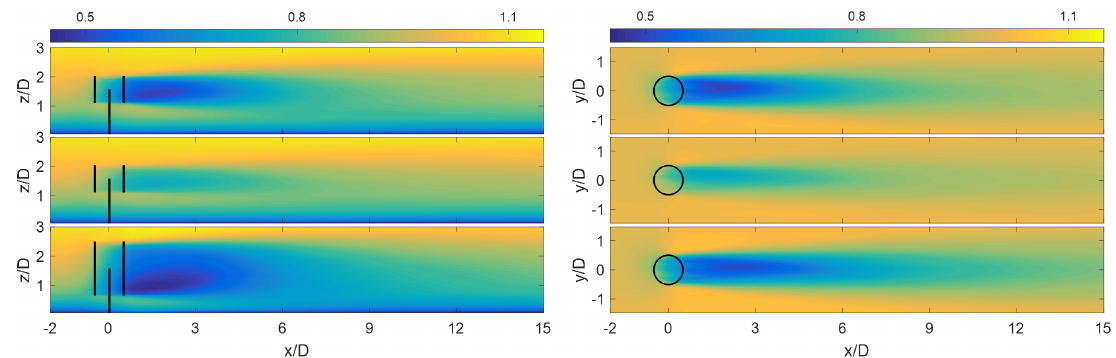
Figure 1. Time-averaged streamwise wind velocity, normalized with the hub-height speed, in the central vertical ( left ) and lateral planes ( right ). From top to the bottom: Case (1), Case (2) and Case (3). The turbines rotate